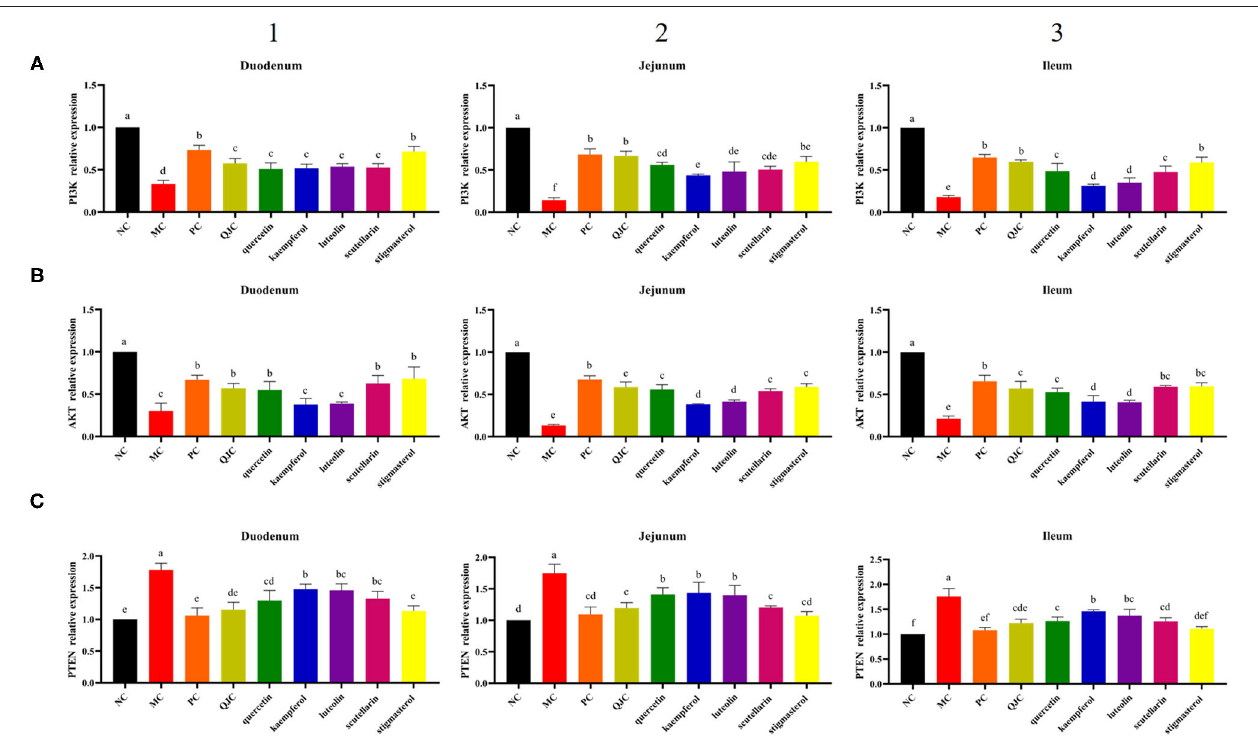
FIGURE 11 | Effect of QJC and its five active ingredients on the mRNA expression in diarrhea mouse small intestine tissues. The significant difference between groups ( p < 0.05) was shown by the different letters above the histogram. (A) The phosphoinositide 3-kinase ( PI3K ) relative expression in the duodenum, jejunum, and ileum. (B) The Akt relative expression in the duodenum, jejunum, and ileum. (C) The phosphatase and tensin homolog ( PTEN ) relative expression in the duodenum, jejunum, and ileum. (1) The PI3K , Akt , and PTEN relative expression in the duodenum. (2) The PI3K , Akt , and PTEN relative expression in the jejunum. (3) The PI3K , Akt , and PTEN relative expression in the